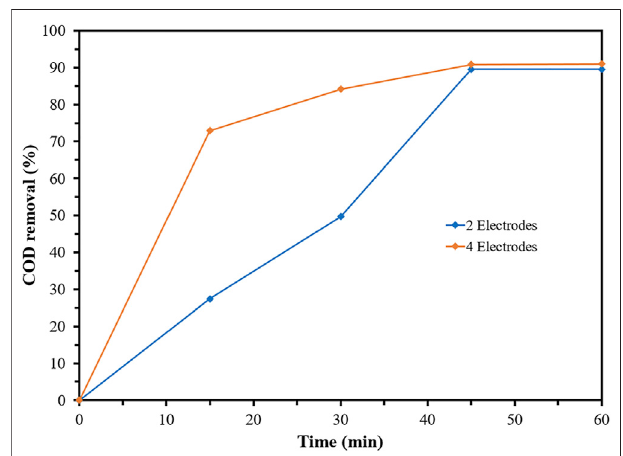
FIGURE 3 | COD removal ef fi ciency of the stirring EC system with different numbers of